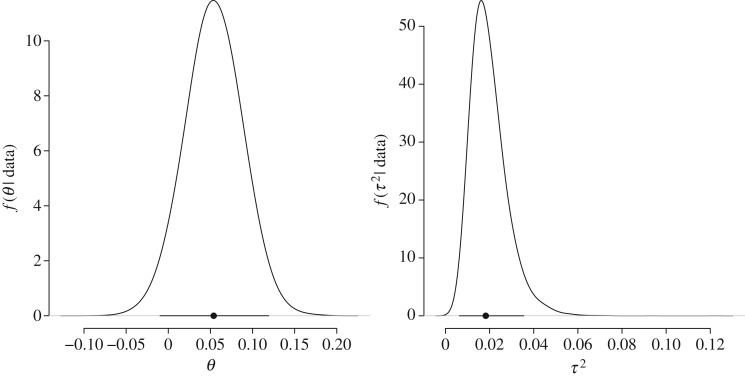
Posterior distributions for the group-level parameters of the hierarchical normal model describing the distribution of the 38 t-test effect sizes in our reanalysis. Posterior medians are indicated with dots and central 95% credible intervals are indicated with horizontal lines.